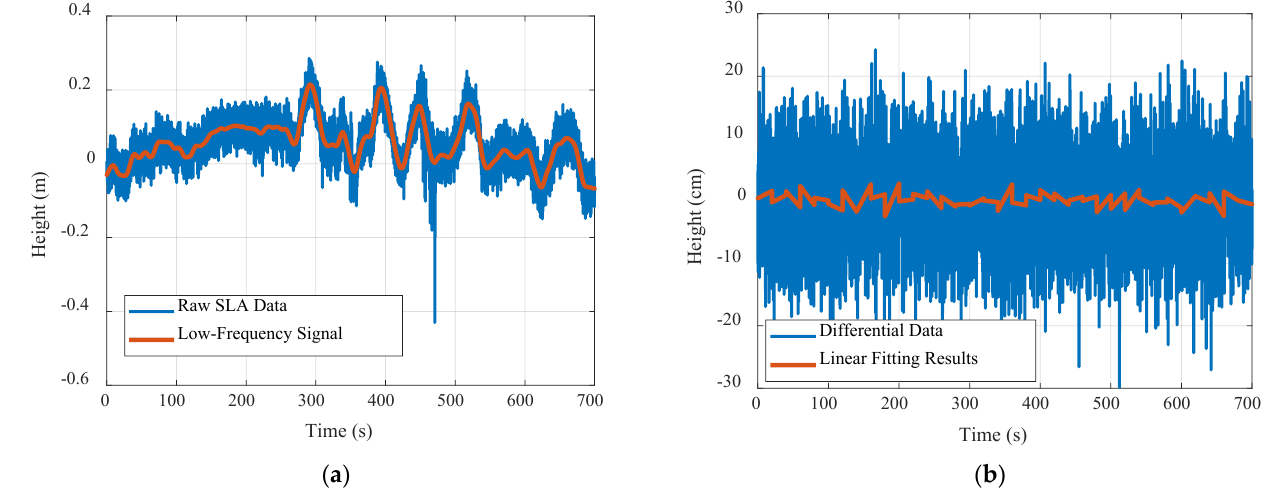
Figure 2. Simulation result of experiment 2: ( a ) the raw SLA extracted form Sentinel-6 (blue curve) and composite low-frequency signal obtained by Butterworth low-pass filtering (red curve); ( b ) the differential data (blue curve) and linear fitting results when the segment duration is 20 s (red curve).